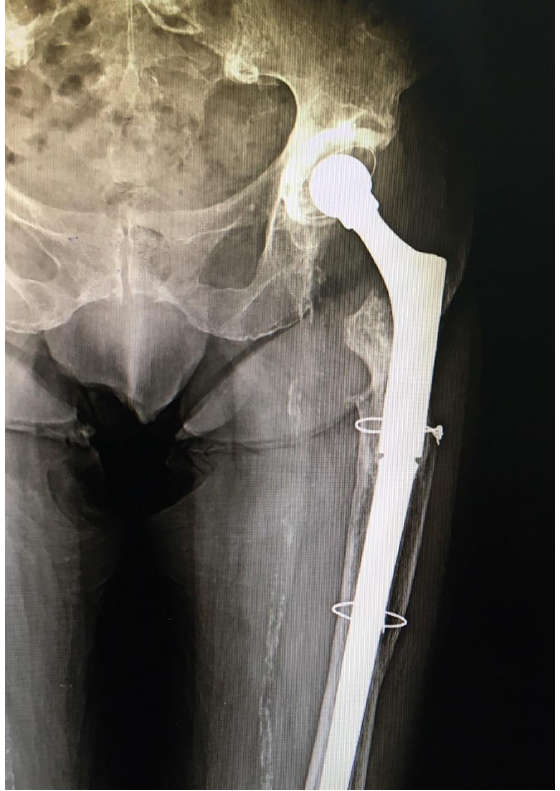
Figure 2. X-ray of the operated hip ten months after the surgery, showing a good position of the revision total hip endoprosthesis and no signs of instability.